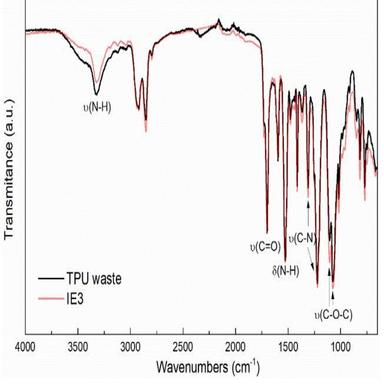
FTIR spectrum obtained for TPU waste and most processed IE3 sample.